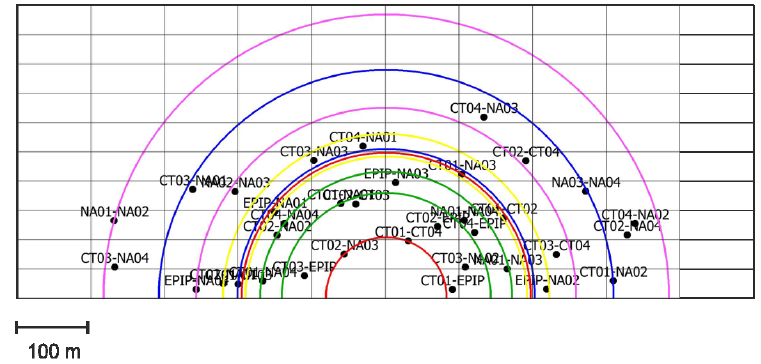
Figure 6. Azimuth-interdistance plot for the array; each dot represents one couple of stations, all dots are divided in five rings.